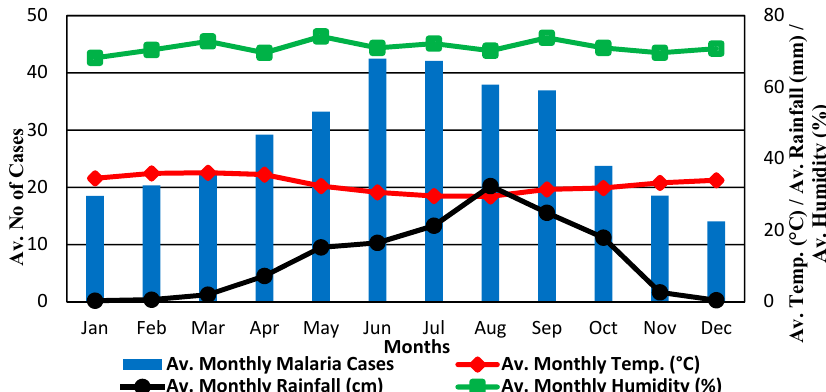
Figure 2. Relationship between the monthly average of malaria incidence and weather variables.